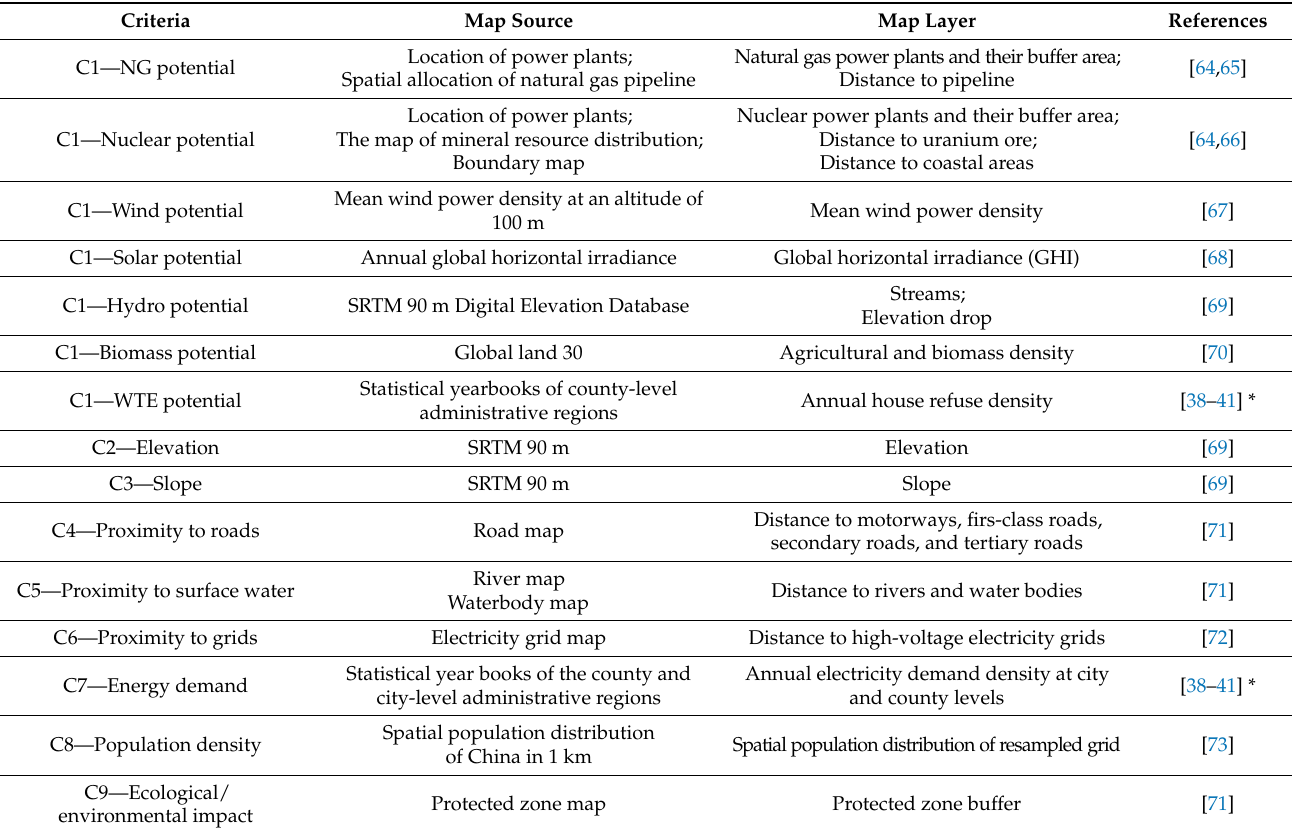
Table 4. GIS data sources for criteria map